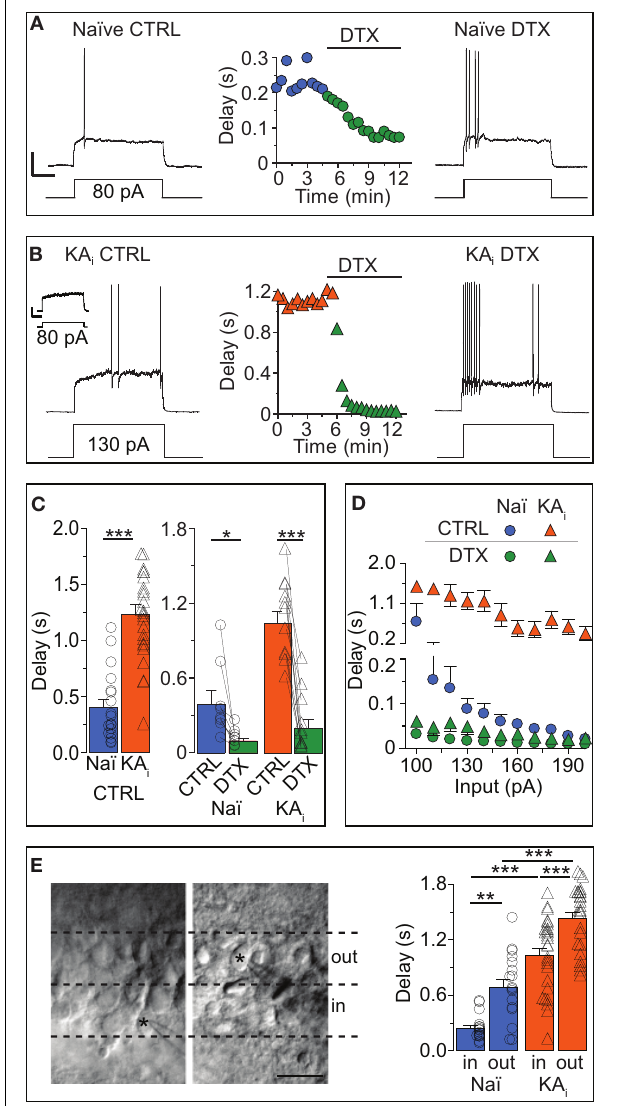
FIGURE 1 | Dendrotoxin (DTX)-sensitive action potential response delays in DG cells of naïve mice and during hippocampal epilepsy. (A–C) Current-clamp recordings in DG cells of naïve [ Naï , (A) , circles ] and KA-injected [ KA i , (B) , triangles ] mice showing the transformation of a delayed action potential (AP) response under control condition ( CTRL , left traces ) into an almost immediate AP response by Kv1 channel blocker DTX (right traces) . Because KA DG cells have a higher rheobase than Naï DG cells (Young et al., 2009), stronger current steps were injected into KA cells for pharmacological delay characterization [130pA in (B) ]. For direct comparison see inset in (B) [response of KA cell to current pulse as in (A) , i.e., 80 pA]; Scale bars in (A,B) inset , 25mV, 0.5s. Compared to Naï DG cells, AP delays of KA DG cells were ∼ 2.5 times prolonged (C) . This was true with rheobase currents (C , right panel ) and with current injections that were not statistically different (C , left panel ) . (D) Over a larger range of current injections, the response delays of KA DG cells were elevated ( orange triangles ) vs. Naï DG cells ( blue circles ) which displayed stronger response acceleration with increasing current injections. This difference was abolished with DTX ( green triangles , KA; green circles , Naï, respectively). (E) Recorded DG cells localized via live fotos of patch (Continued)